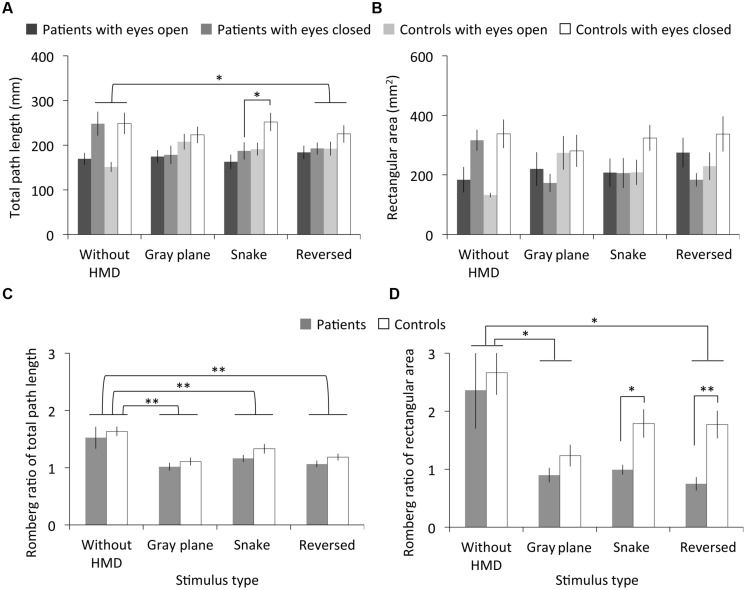
Results of Experiment 2. (A) Total path length, (B) rectangular area, and (C,D) their Romberg ratios for patients with migraine and normal controls as a function of stimulus type. Error bars denote ±1 SEM. Asterisks indicate significant differences (∗p < 0.05, ∗∗p < 0.01).